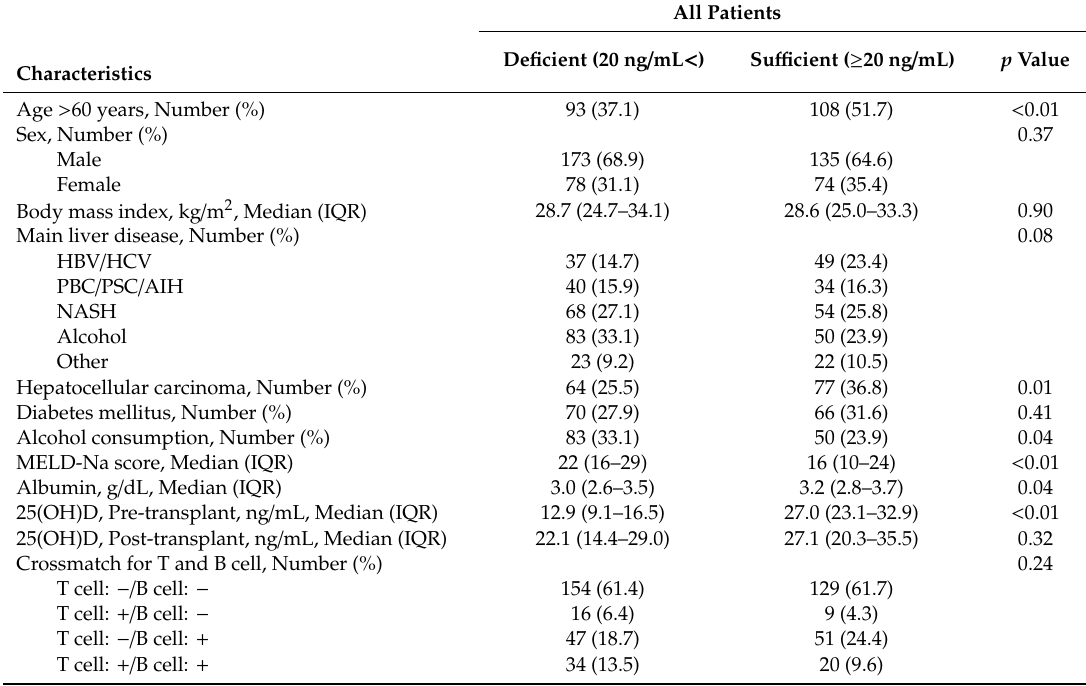
Table 2. Characteristics of vitamin-D-deficient and -su ffi cient patients prior to liver transplantation.